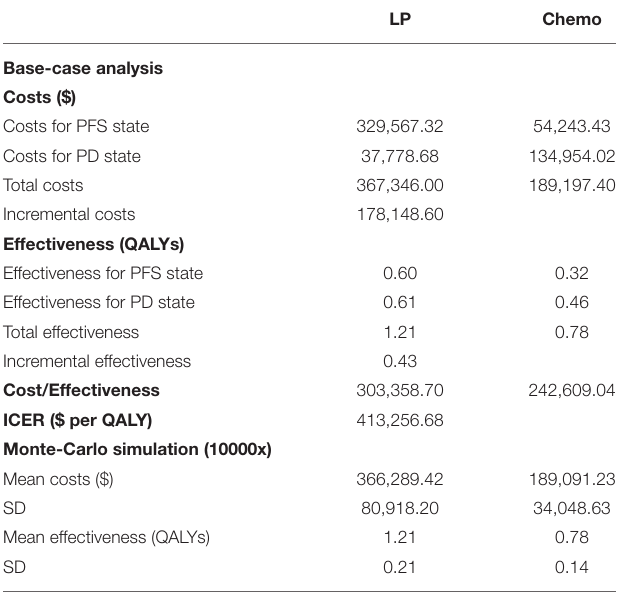
TABLE 4 | Results of the cost-effectiveness analysis in patients with